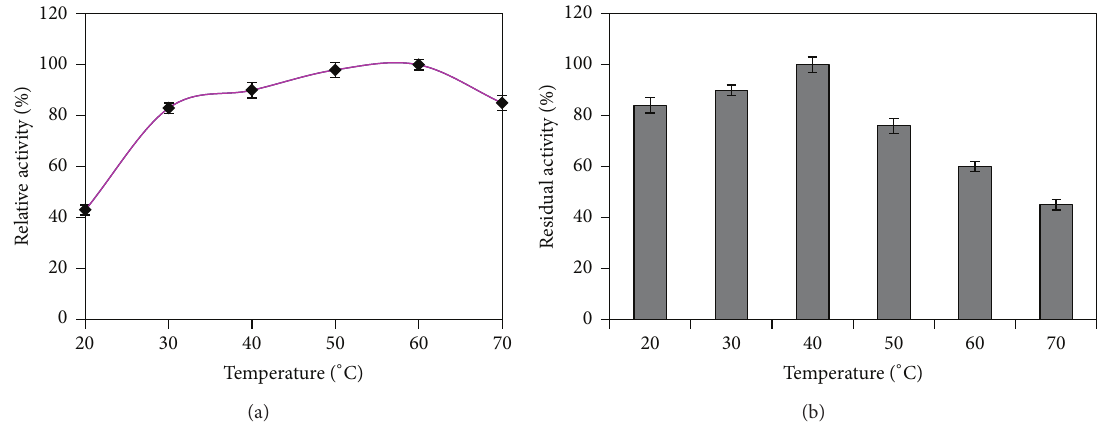
Figure 5: Effect of the activity (a) and stability (b) of the crude protease by temperature from strains SD11. (a) The activity of the enzyme was tested at various temperatures (20–70 ∘ C). The enzyme activity was maximum at 60 ∘ C regarded as 100%. (b) The protease stability against temperature was examined after the crude enzyme was incubated under temperatures between 20 and 70 ∘ C for 1h. The residual activity was tested under the normal conditions. The enzyme activity without incubating was regarded as 100%. Each point indicates the average value of three times, and error bars show standard